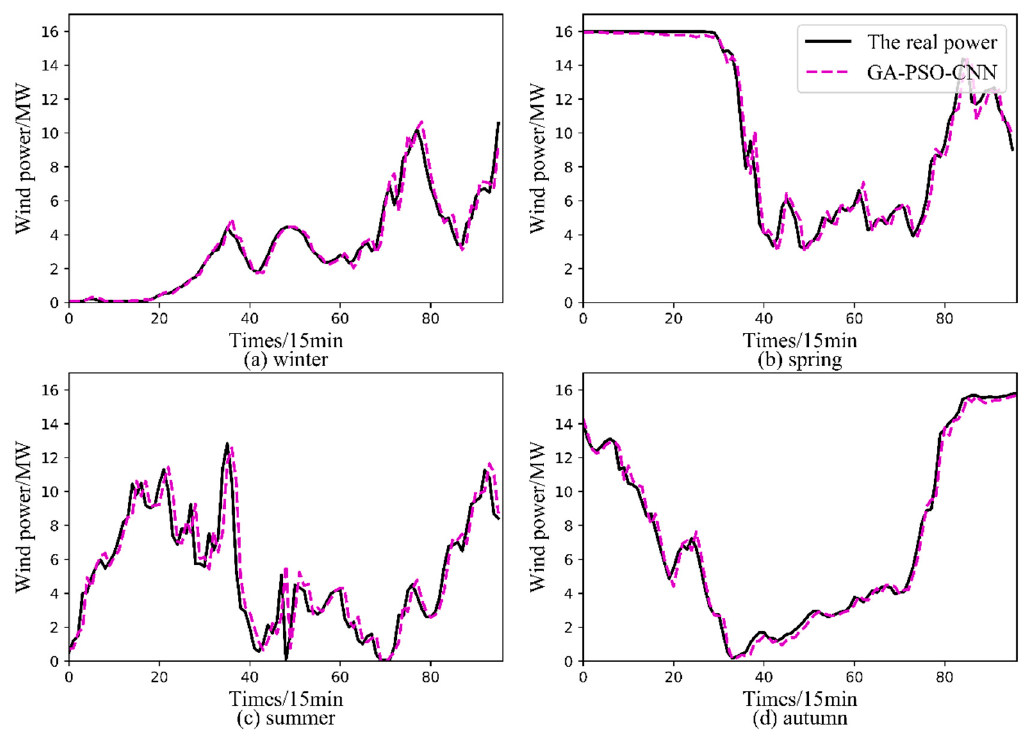
Figure 10. Wind power fitting curves for GA–PSO–CNN model in different seasons. ( a – d ) are wind power fitting curves for the model in winter, spring, summer and autumn respectively.